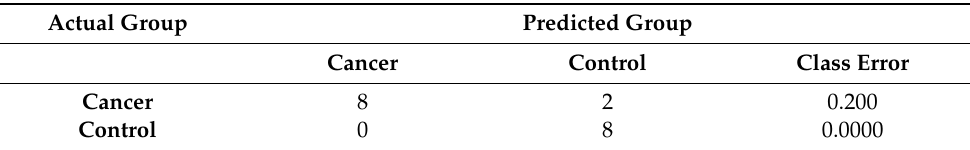
Table 8. Random forest prediction accuracy applied on the testing set made from 20% of endometrial cancer cases and controls after exclusion of women with type 2 diabetes mellitus ( n = 18, cancers = 10, controls = 8).